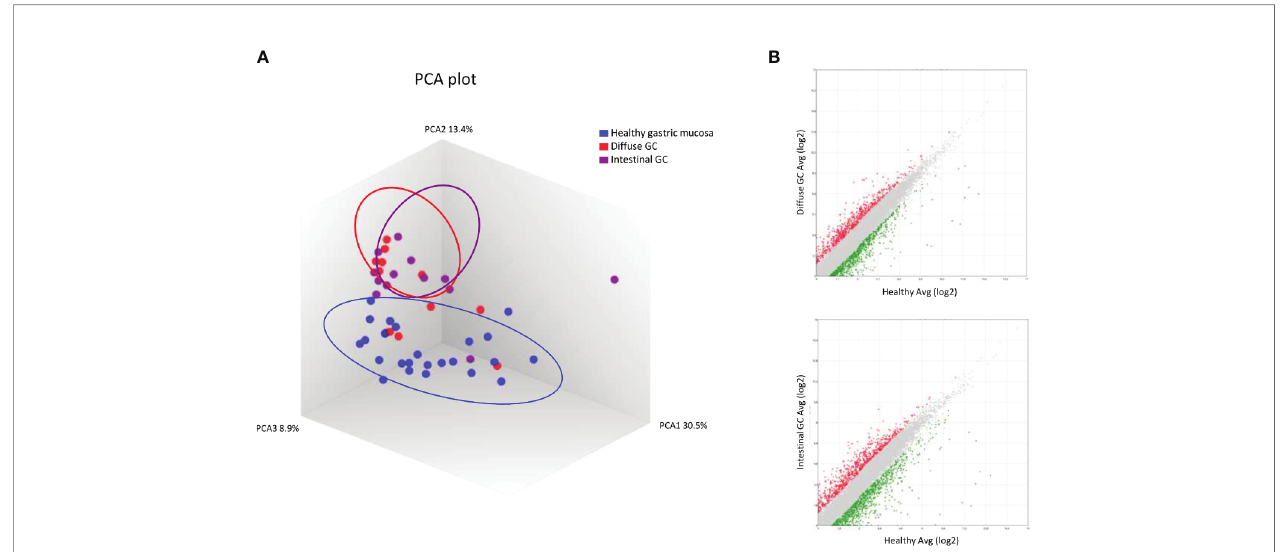
FIGURE 1 | RNA sequencing of Diffuse and Intestinal Gastric Cancer. (A) Heterogeneity characterization of gastric samples showed by principal component analysis (PCA) plot. (B) Scatter plots of transcripts differentially expressed between diffuse gastric cancer and healthy mucosa or intestinal gastric cancer and healthy mucosa. (Fold Change < − 2 or >+2, p value <